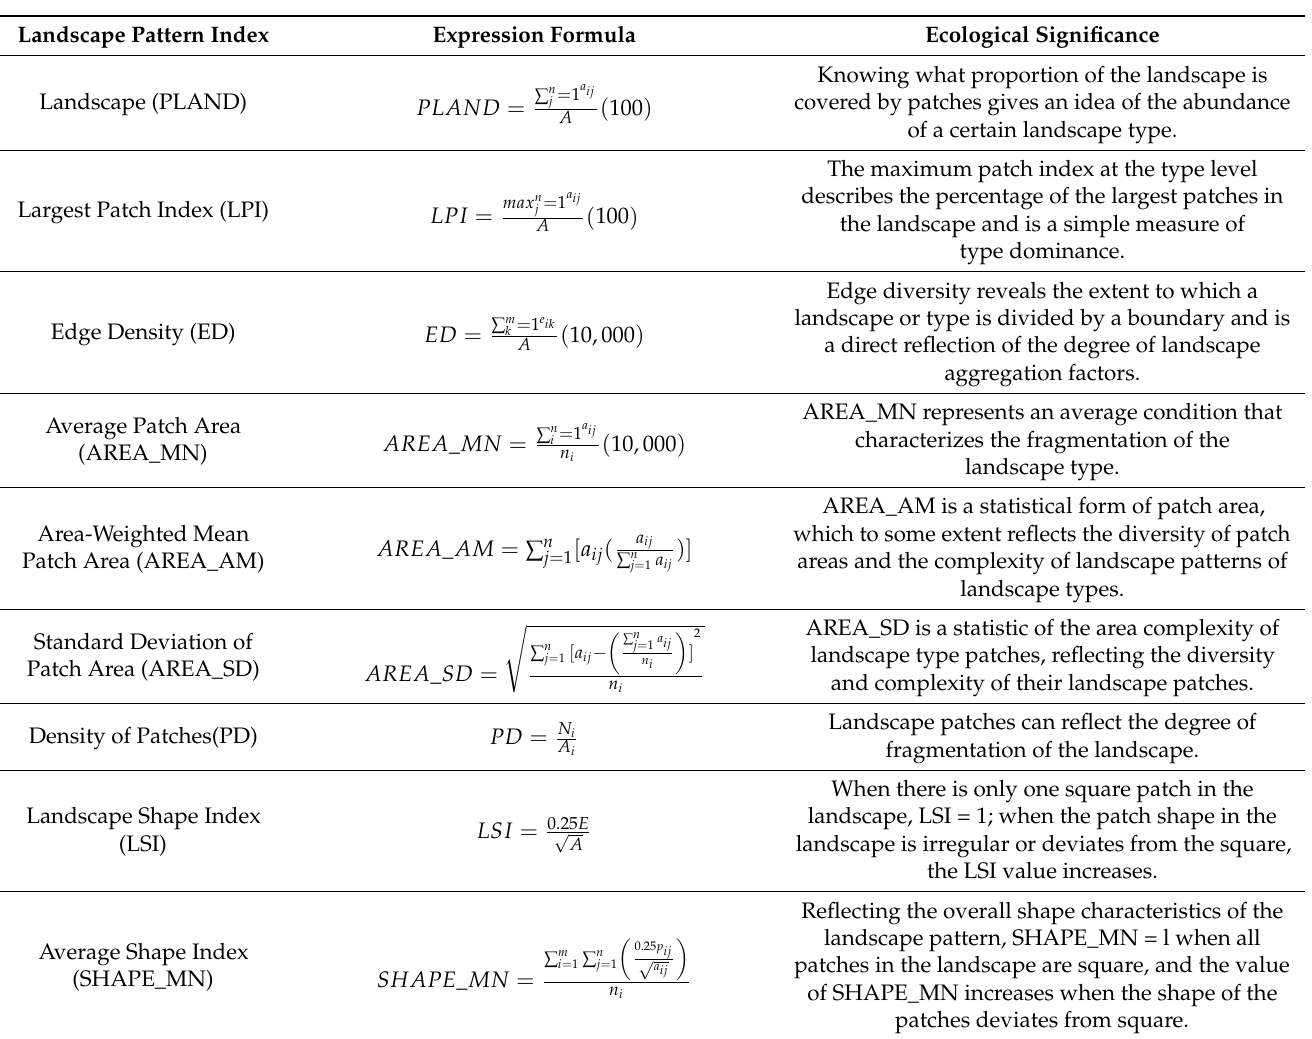
Table A2. Landscape pattern index analysis